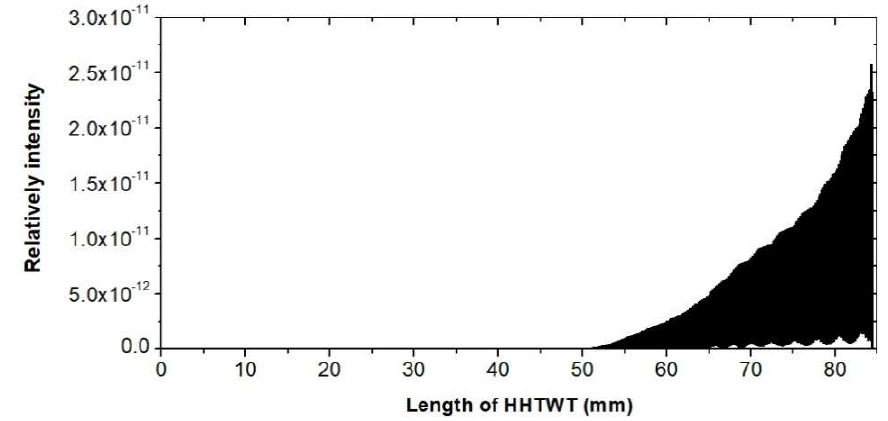
Figure 7. Power curve of the HHTWT at 346 GHz.